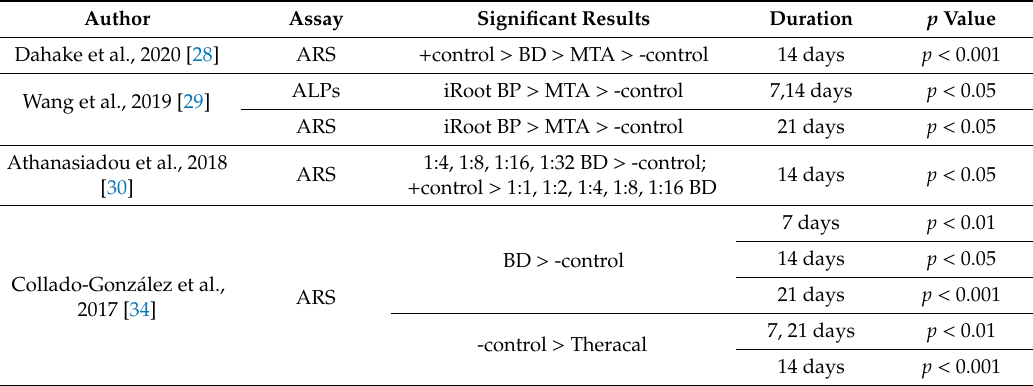
Table 4. Significant results in bioactivity